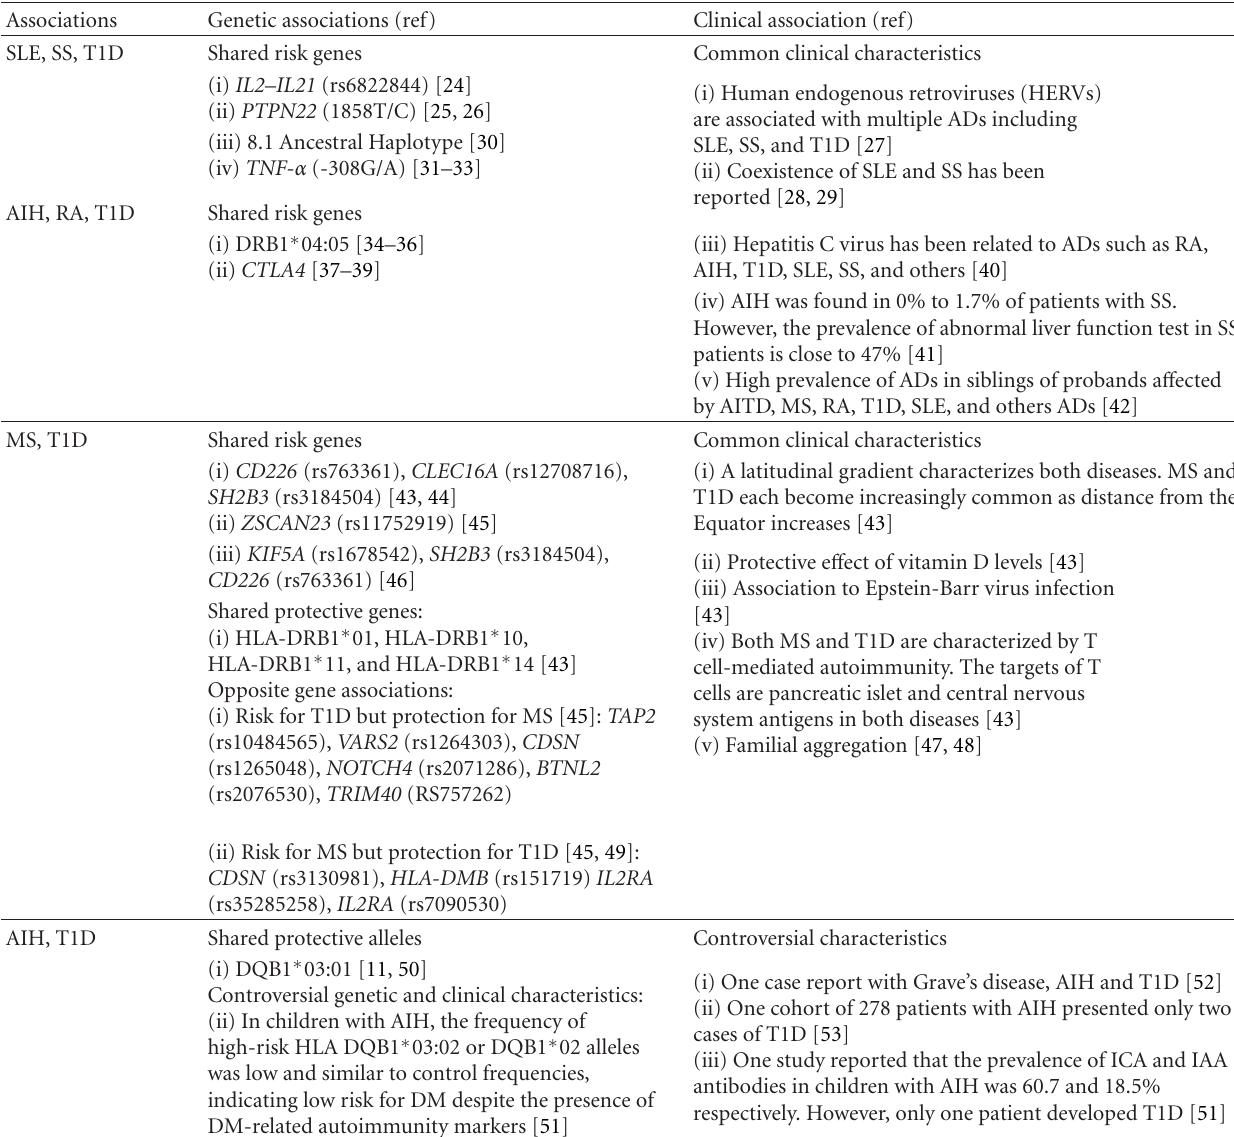
Table 2: Relationship between genetic and clinical features with HLA-ADs